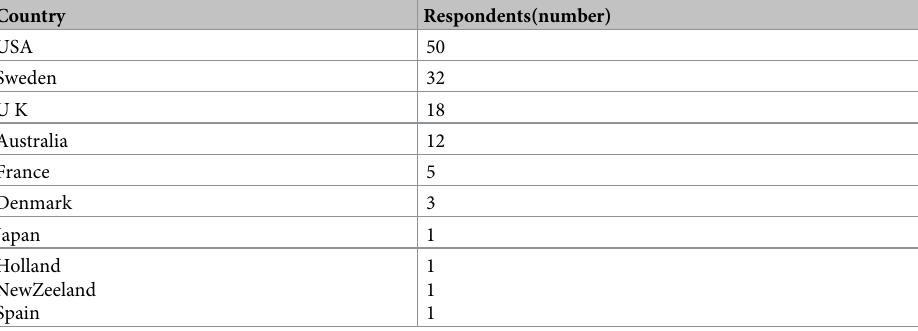
Table 3. Medical informants’ main country of